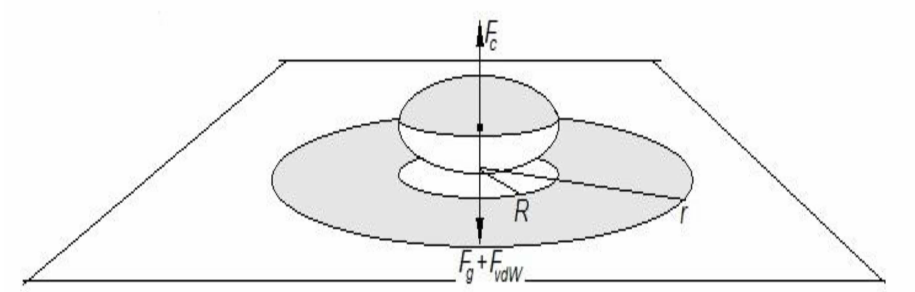
Figure 1. A microparticle lies on a plain surface under UV irradiation. During fluctuations, the charge density σ s simultaneously and approximately equally increase both on the dust particle itself and on some annular portion of the R-r surface around it (grey area). F c —the Coulomb force, F vdW —the van der Waals force, and F g —the gravity